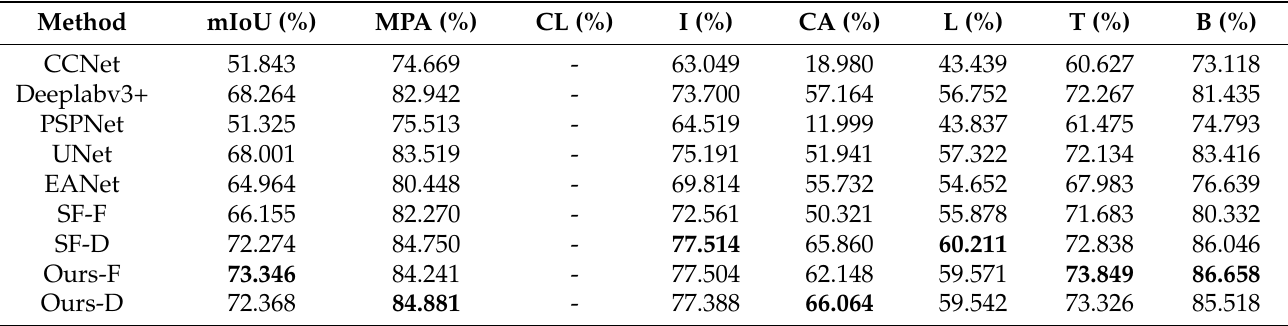
Table 8. Results of other models on Vaihingen dataset. CL means clutter. I means impervious surface. CA means car. L means low vegetation. T means tree. B means building. The highest scores are marked in